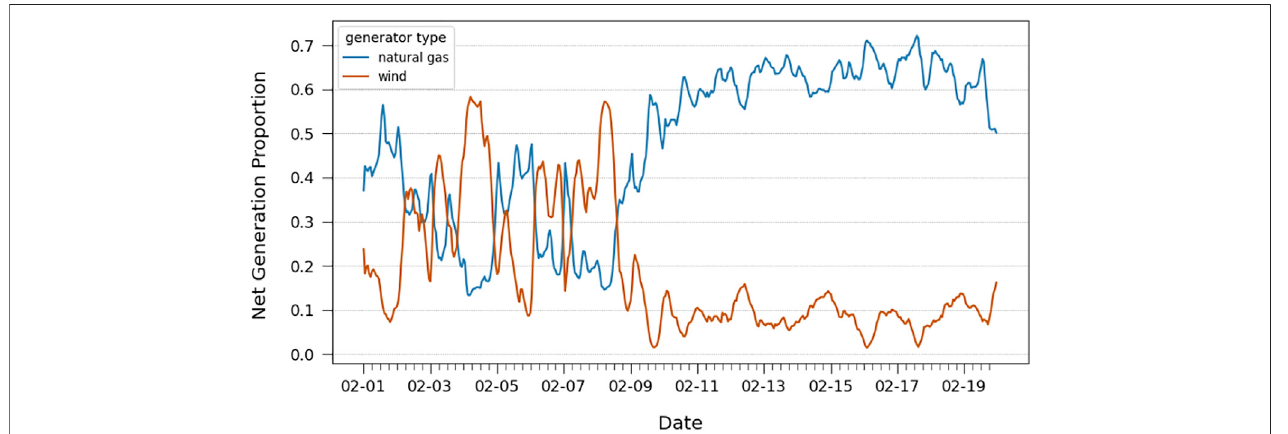
FIGURE 3 | Net generation